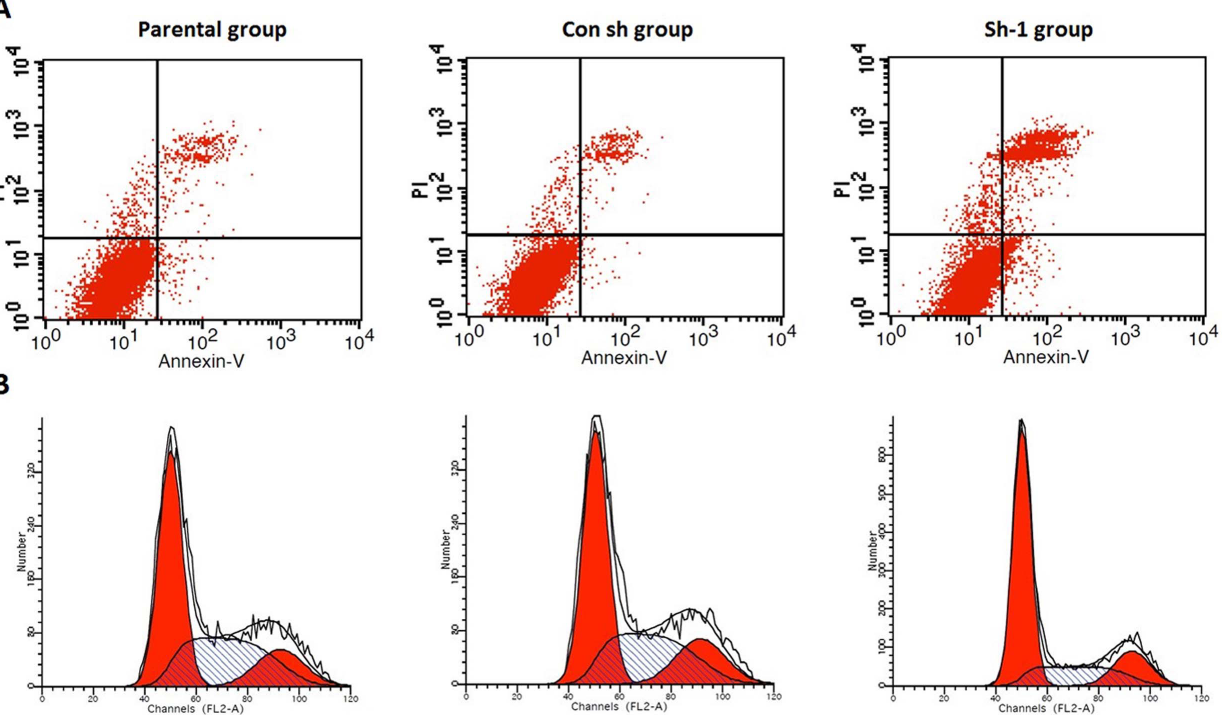
Figure 6. Effect of Prx-I-shRNA transfection on the apoptosis and cell cycle of T24 cells. A: Prx-I knockdown induced apoptosis in T24 cells. B: Representative pictures of FACS analysis showing Prx-I knockdown induced G0/G1 cell cycle arrest in T24 cells with a corresponding decrease in S- phase cells (P , 0.05).